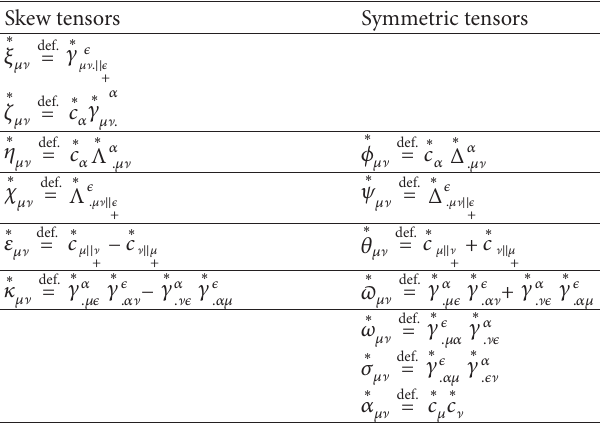
Table 1: PAP second order world tensors